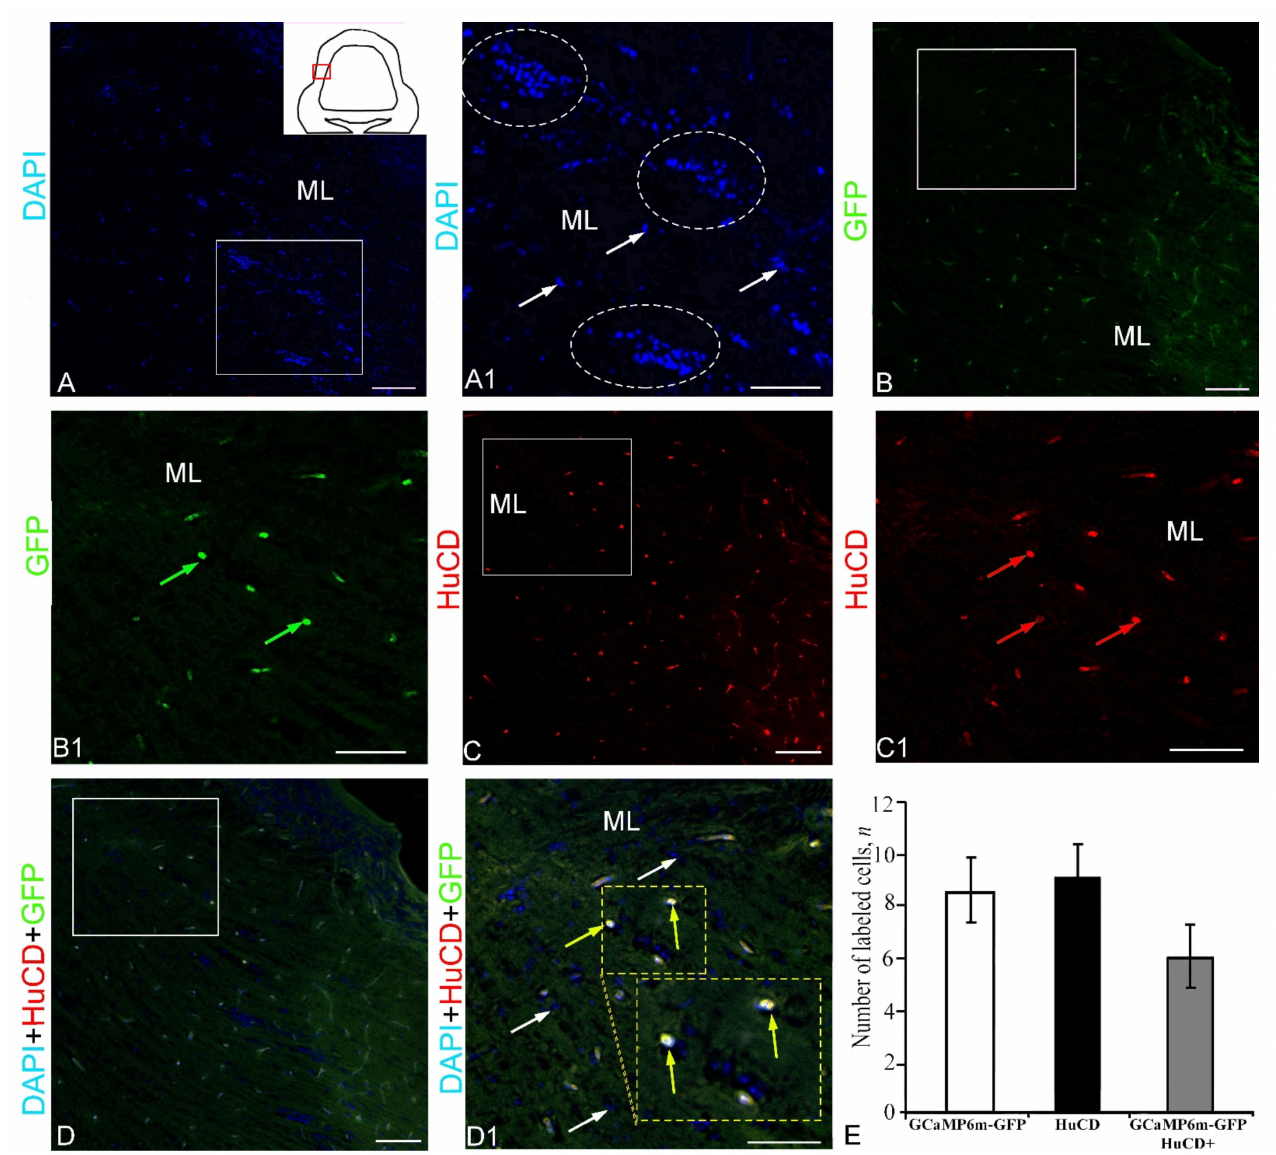
Figure 4. Z-stacks showing DAPI staining, localization of green fluorescent protein GFP and HuCD, and their co-localization in the lateral region of the cerebellum in juvenile chum salmon, O. keta , 90 days after a single injection of the rAAV into the cerebellar body. ( A ) DAPI staining with a pictogram showing the lateral region of the cerebellum (in a red box), clusters of DAPI-positive nuclei (outlined by the white box); ML, molecular layer. ( A1 ) The enlarged fragment outlined by a white box in A; white dotted line outlines reactive neurogenic zones; single DAPI+ nuclei (white arrows). ( B ) GFP immunolocalization in cells of the lateral zone (in white box). ( B1 ) The enlarged fragment outlined by a white box in B (GFP+ cells are indicated by green arrows). ( C ) HuCD immunolocalization in the lateral cerebellum (white box). ( C1 ) An enlarged fragment outlined by a white box in C; HuCD+ cells (red arrows). ( D ) Co-localization of GFP and HuCD in cells of the lateral zone (in white box). ( D1 ) The enlarged fragment in a white box. ( D ) Cells with co-localization (yellow arrows) are bordered by yellow dotted lines (inset); DAPI+ nuclei (white arrows). Laser scanning confocal microscopy. Scale bar: ( A , B , C , D ) 100 µ m; ( A1 , B1 , C1 , D1 ) 50 µ m; ( E ) One-way ANOVA showing the relative distribution of GFP and HuCD immunolabeled cells (M ± SD) in the lateral region of the cerebellum of juvenile chum salmon, O. keta . No significant intergroup differences in GCaMP6m-GFP and HuCD, GCaMP6m-GFP and GCaMP6m-GFP/HuCD+ were found ( n = 5 in each